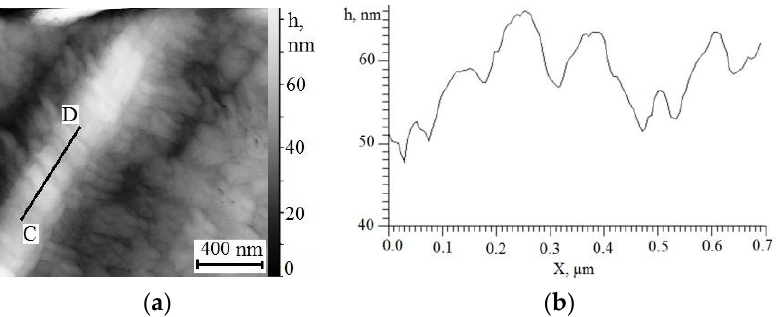
Figure 5. ( а ) STM image of the thin end of the needle subunit; ( b ) cross-sectional profile along line CD shown in Figure 5а.